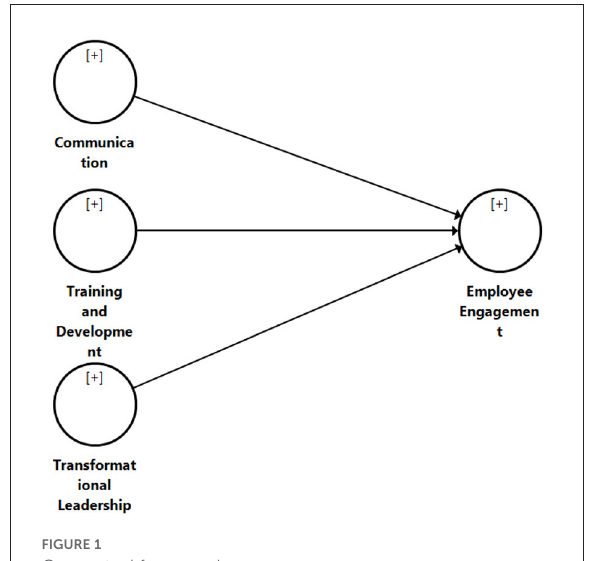
FIGURE1 Conceptual